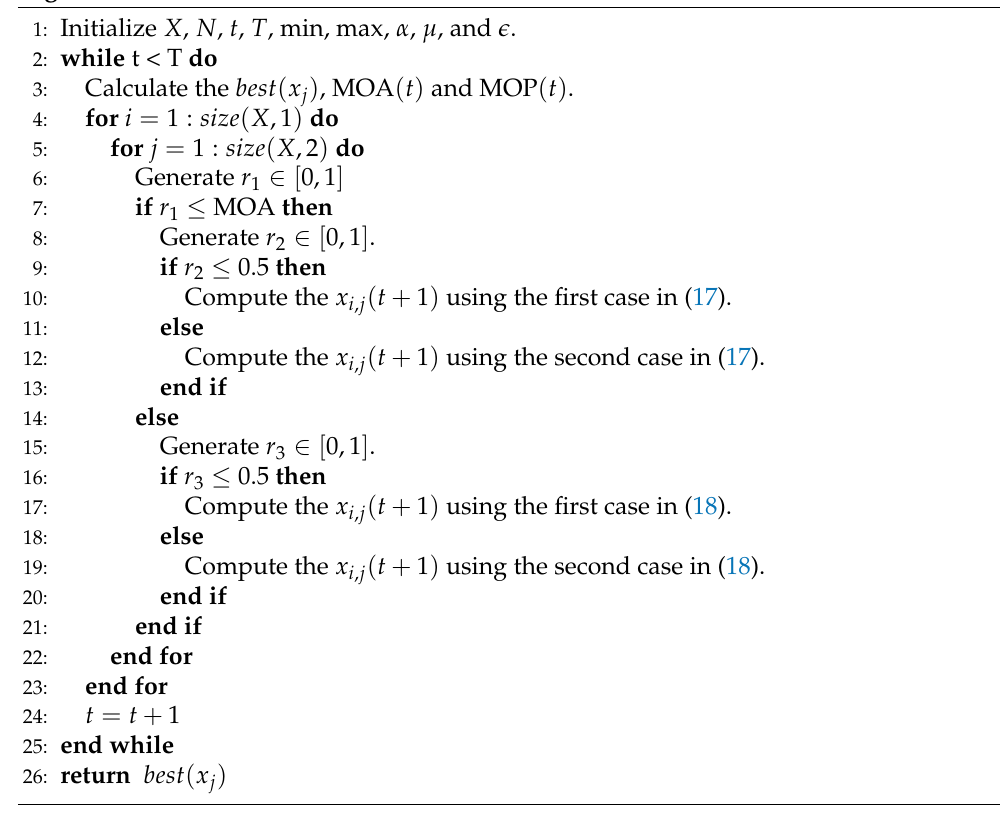
Algorithm 1 Pseudocode of